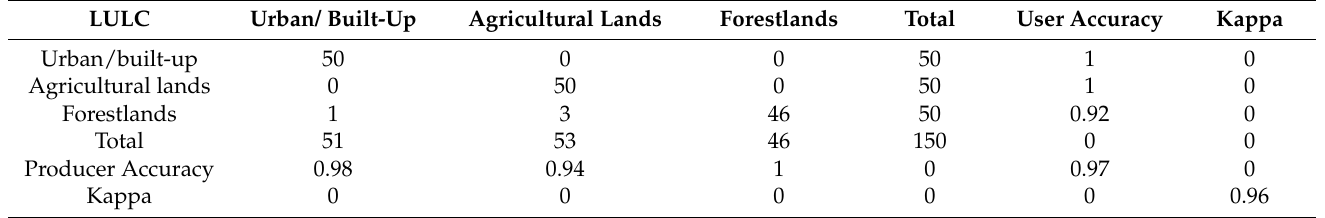
Table A2. User, Producer and Kappa statistics for the classified image of 2013.